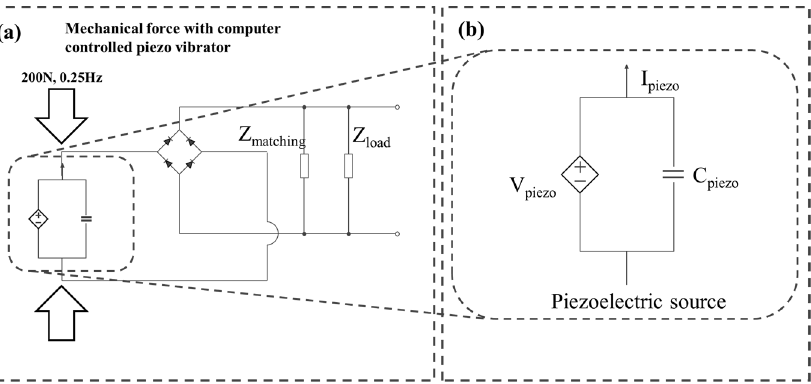
Figure 7. ( a )The schematic diagram of the piezoelectric energy harvesting system. ( b ) Detailed equivalent images of piezoelectric source part in ( a ).